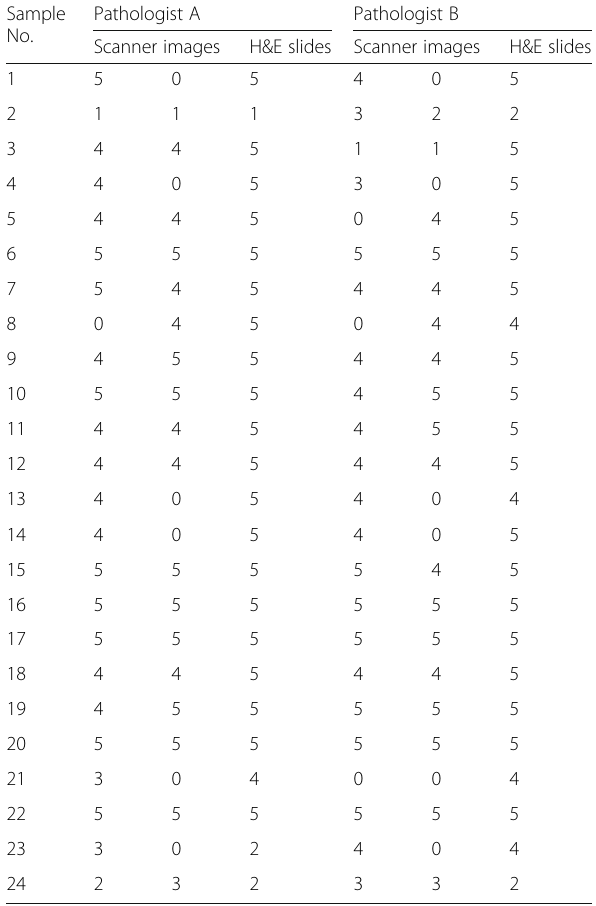
Table 2 Results: correlation table of B-classification results (B-classification from 1 = normal tissue to 5 = malignant) Sample No.